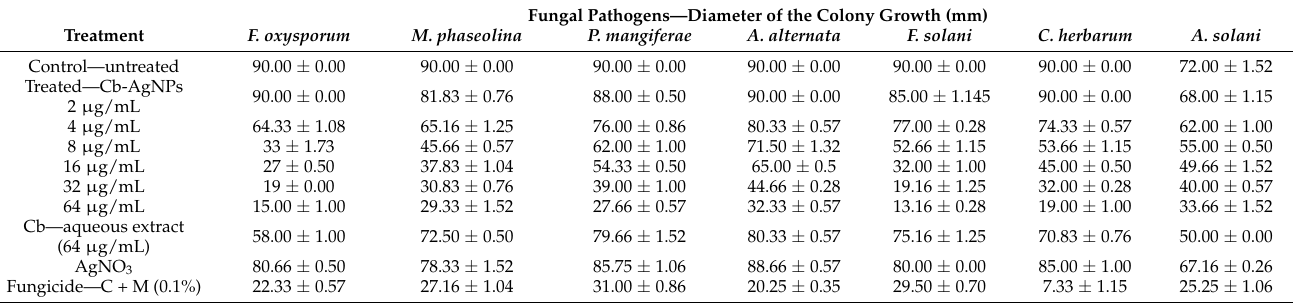
Table 1. The diameter of the colony growth of fungal isolates treated with cranberry Ag NPs, cranberry extracts, AgNO 3 and the